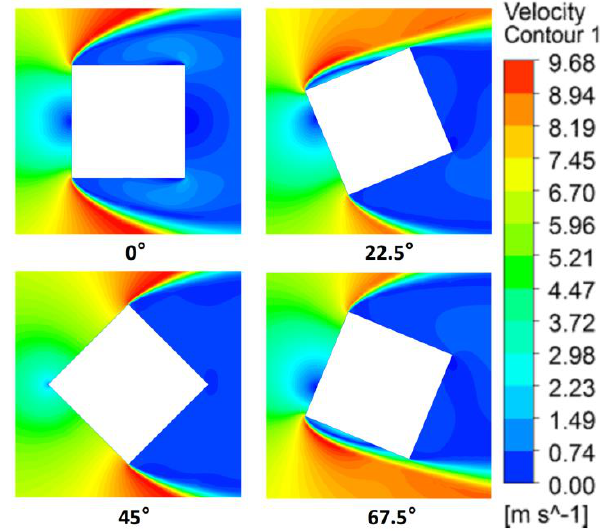
Figure 9. Contours of velocity around the building under different wind directions.